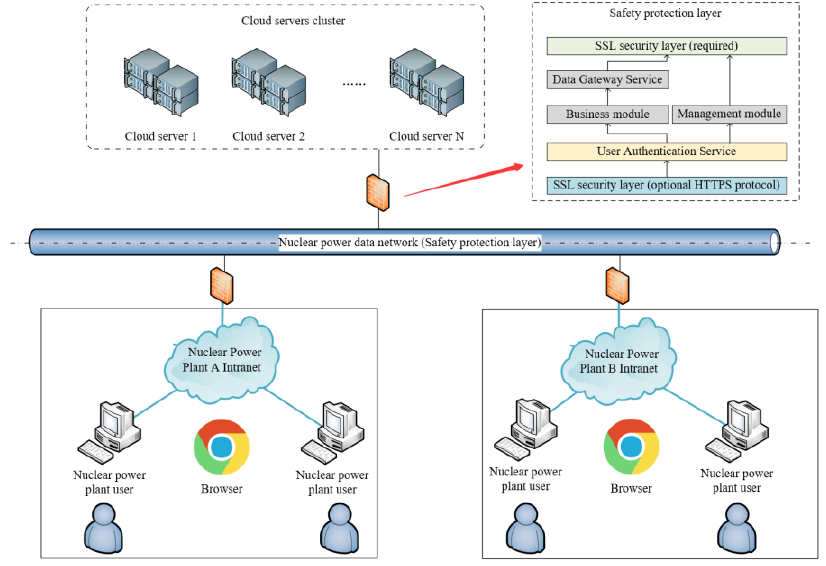
Figure 2. Relay Protection Setting Calculation System Framework Diagram of Nuclear Power Plant.